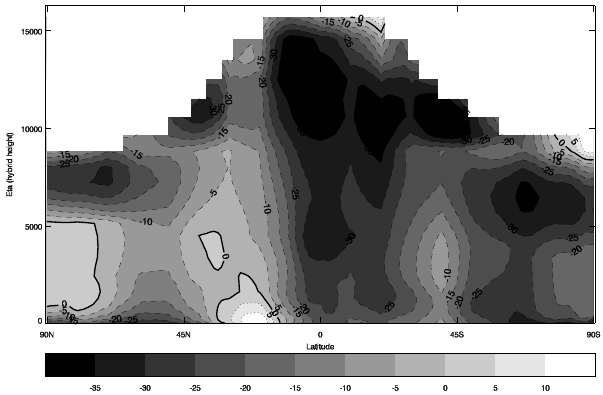
Fig. 27. Percentage difference in zonal annual mean O 3 between UKCA and the Fortuin and Kelder (1998) climatology, i.e. 100(model-climatology)/climatology. For the purposes of the comparison, the stratosphere (taken as O 3 > 150ppbv ) was masked.